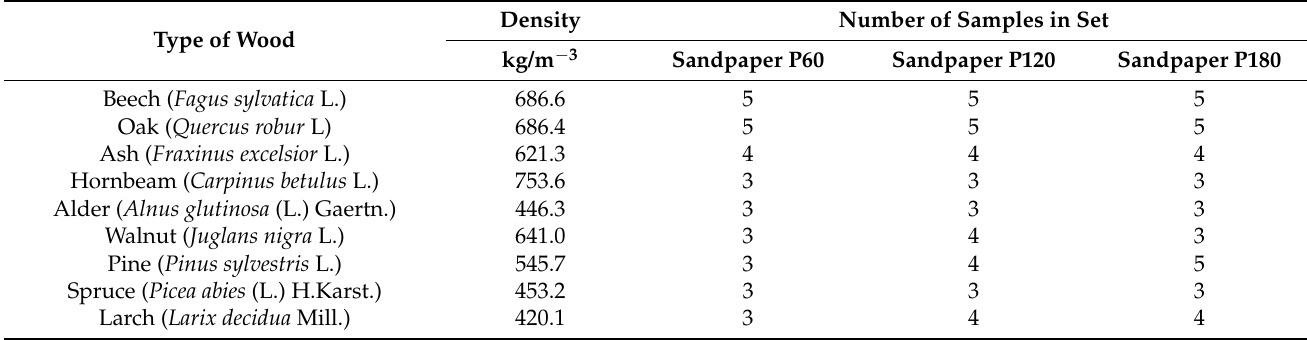
Table 1. Characteristics of wood specimens used in sandability tests.